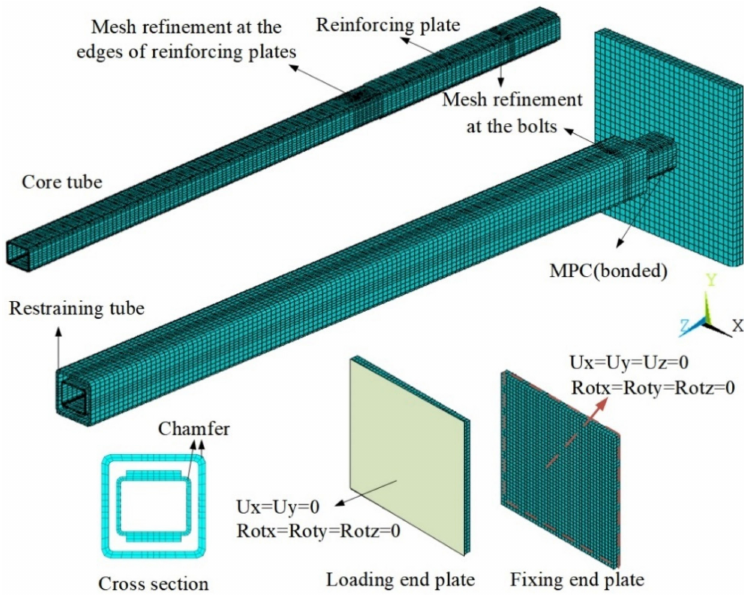
Figure 9. Finite element model (half).